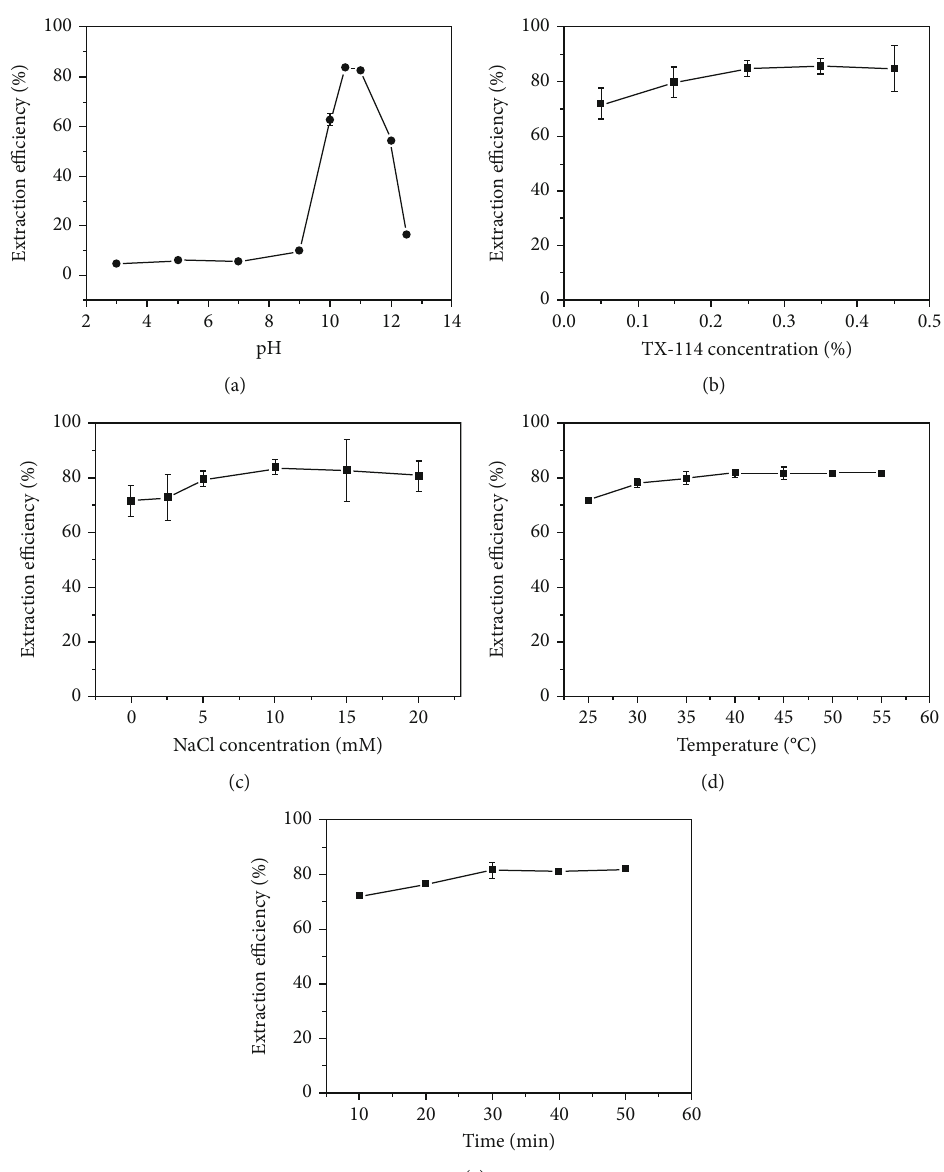
Figure 1: Optimization of CPE factors on the extraction of ZnONPs: (a) pH, (b) TX-114 concentration, (c) NaCl concentration, (d) bath temperature, and (e) equilibrium time ( n = 3